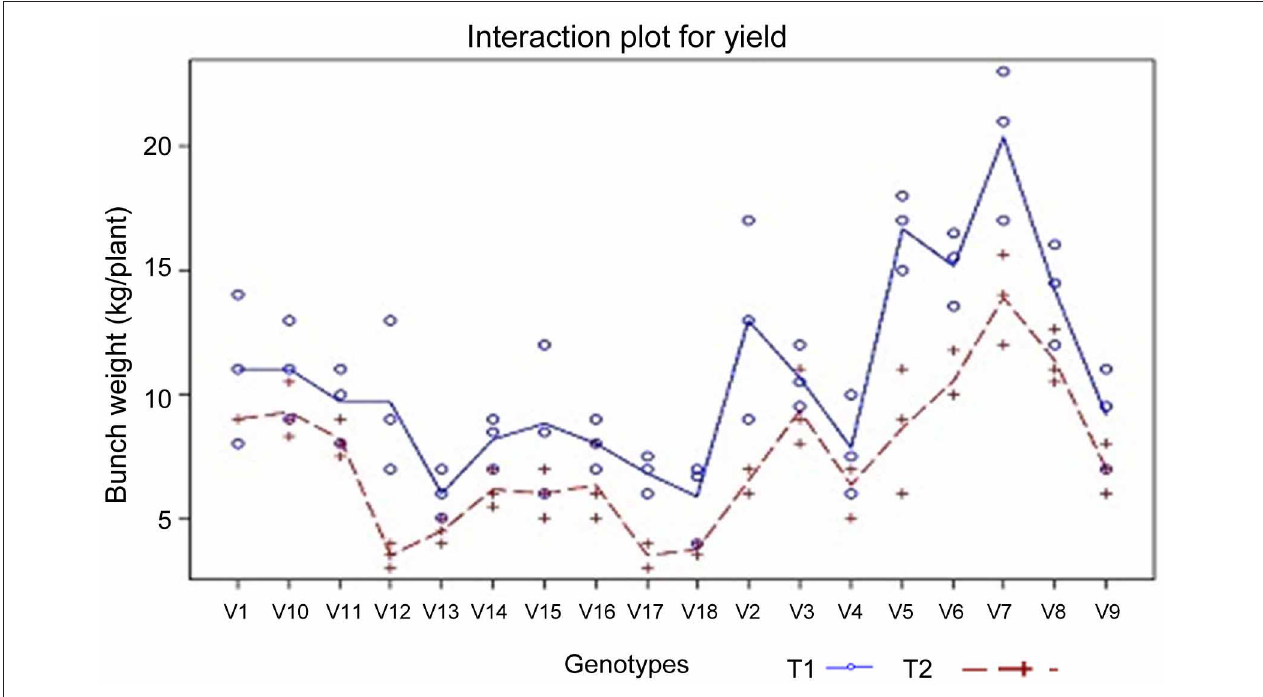
FIGURE 3 | Interaction plot for yield (bunch weigh in kg; n = 3) under different treatments (TRE ), i.e., irrigated (T1-blue solid line) and drought stress (T2-red dotted line; soil moisture deficit stress imposed at six month old plants for three weeks and soil matric potential reached − 0.6MPa at the end of stress period) condition in different banana genotypes (VAR); V1—PaghalapahadWild (BB); V10—Poovan